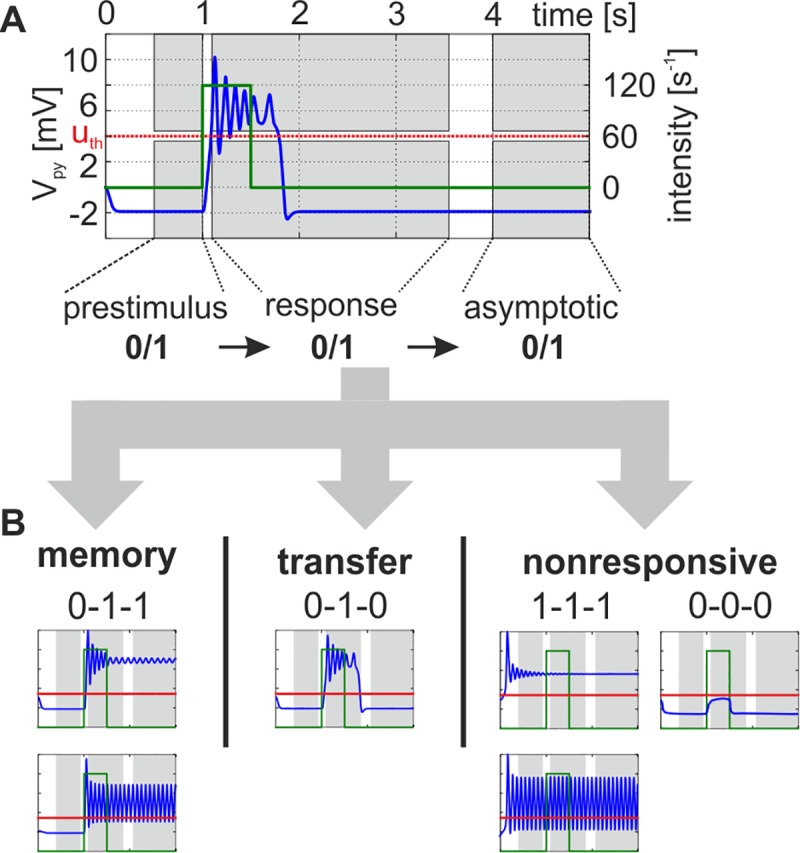
Stimulation principle and categorization of the dynamic response behavior.A) The model received a rectangular stimulation of varying intensity and duration (green line). The maximum of the mean membrane potential of the pyramidal cell population (blue line) was recorded in three time windows, i.e. prestimulus window, immediate response window, and the asymptotic window (gray shaded areas). To classify the response behavior, these activation values were compared to a threshold of 4mV (red horizontal line, uth) in each window–‘0’ denoting a subthreshold activation and ‘1’ denoting an activation exceeding the threshold. B) The combined evaluation of the activities (e.g., ‘0-1-1’) led to three distinct classes of response behaviors: memory, transfer, and nonresponsive behavior. For the plotted curves we used b1 = 1, b2 = 1, He = 3.25mV, and Hi = 22mV.